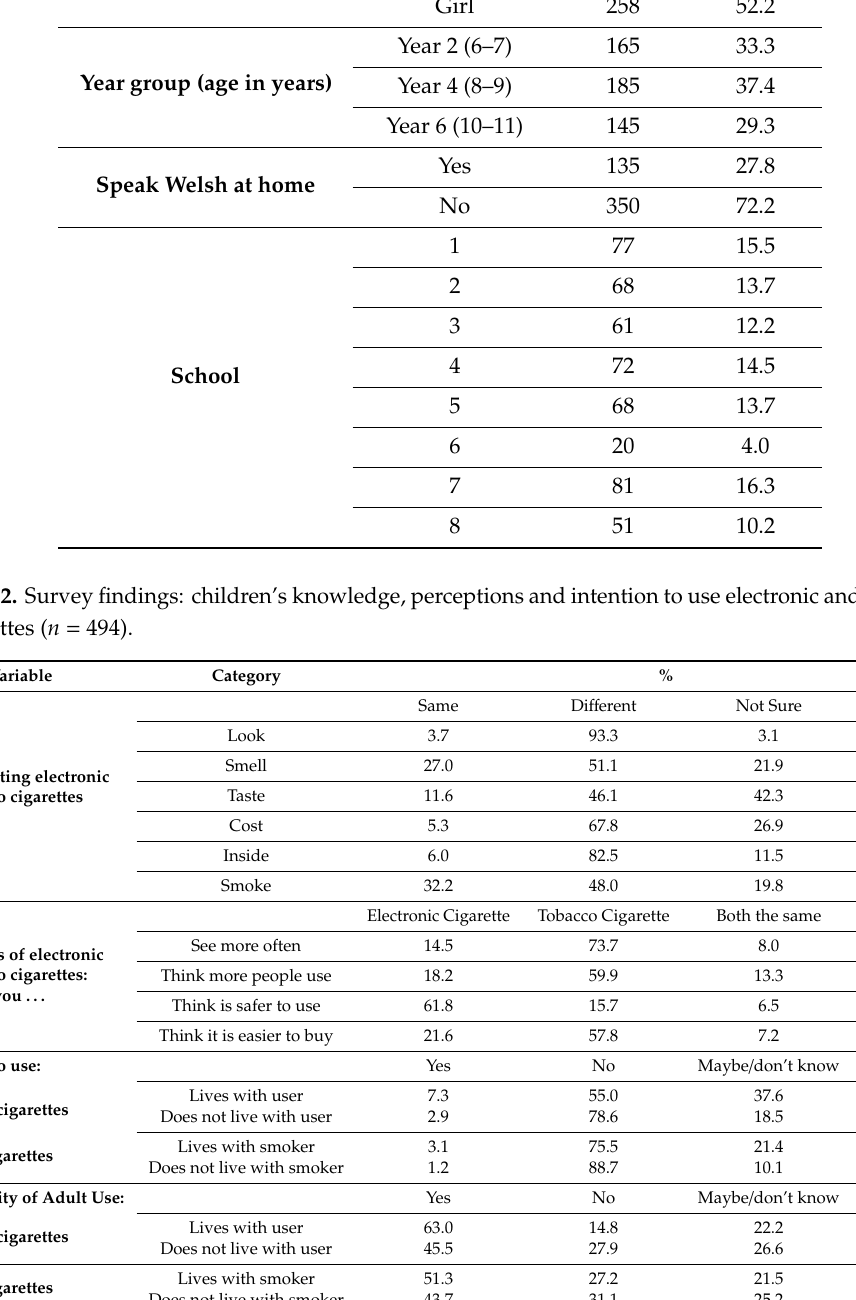
Table 1. Participant and school information.